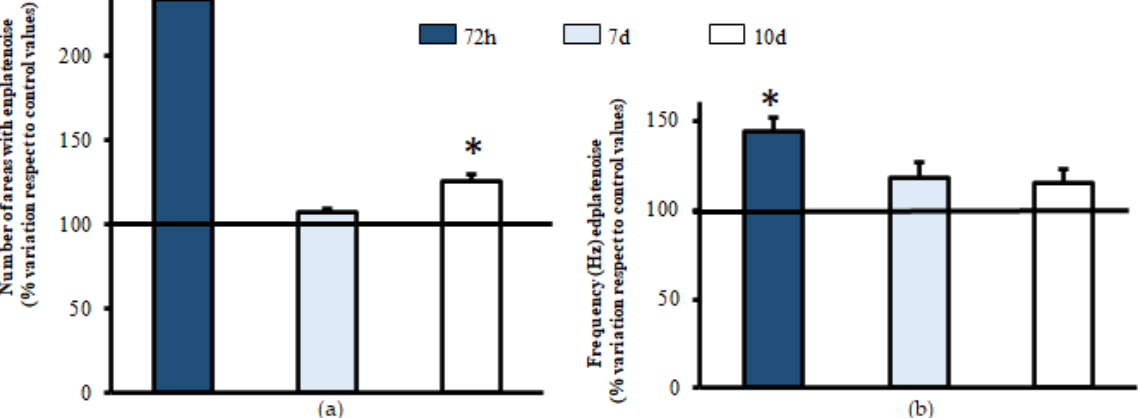
Figure 5. Action of electrical currents in muscles treated with bupivacaine. Intramuscular injections of bupivacaine were performed in both gastrocnemius muscles of each animal. After 48 h, the PNE protocol was applied (1.5 mA for 5 s, 3 repetitions). At 72 h and 7 and 10 days after inoculation with BPV, needle electromyography was performed. Comparative recordings were performed between the limb untreated with electric currents (left, control) compared to the treated limb (right, experimental) for each animal. The number of areas presenting endplate noise was evaluated ( a ). During the endplate noise recording, the frequency was studied as the number of potentials that appeared per second, expressed in Hz ( b ). For each column, n = 36 muscular areas from 3 animals. Values are expressed as the mean ± SEM. * p < 0.05 compared to the control values.